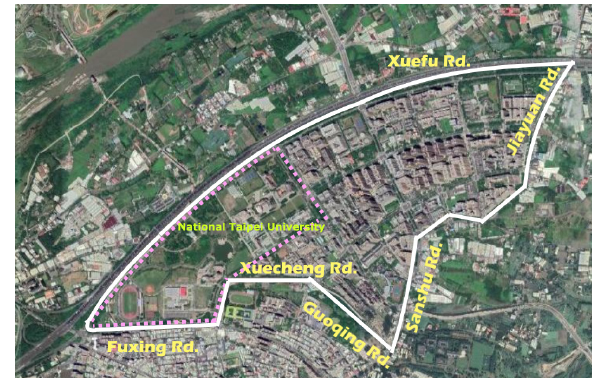
Figure 1. Background of National Taipei University Special Zone